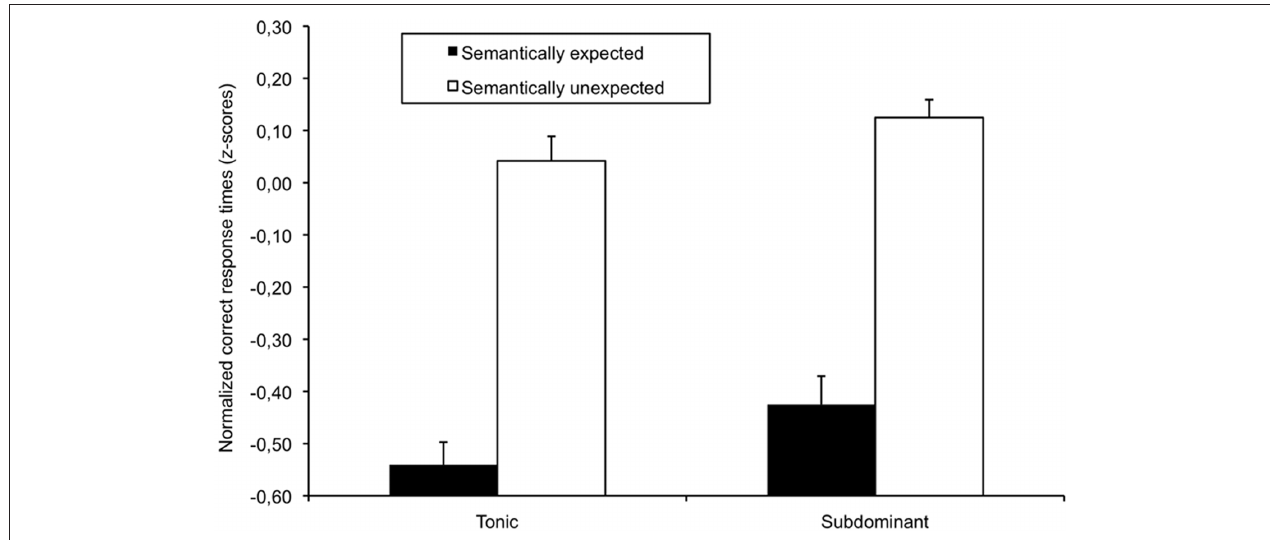
Figure 2 | Normalized correct response times ( z -scores) for words presented as a function of semantic expectancy (expected, unexpected) and tonal function (tonic, subdominant) for experiment 2. Error bars indicate